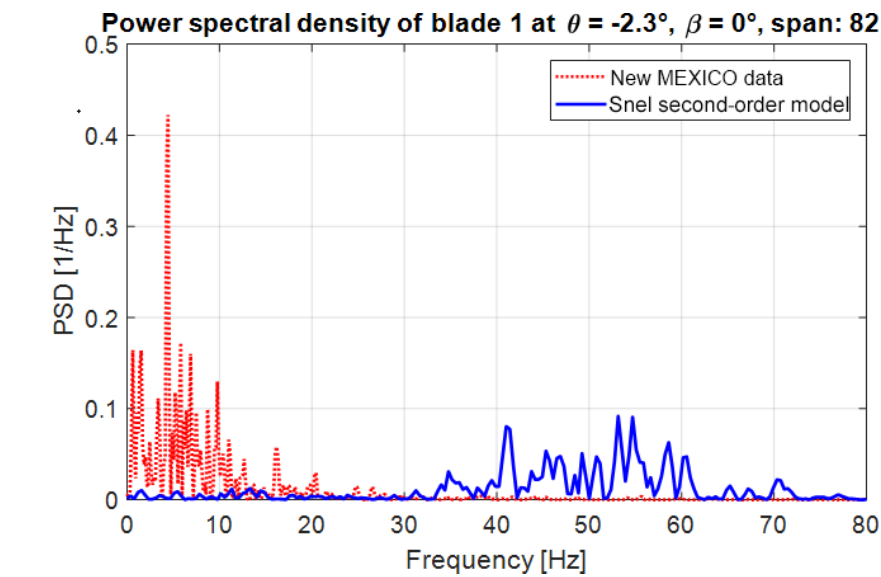
Figure 14. Power spectral density at 82% span of the blade at 0 ◦ azimuth with − 2 . 3 ◦ pitch and 0 ◦ wind direction.